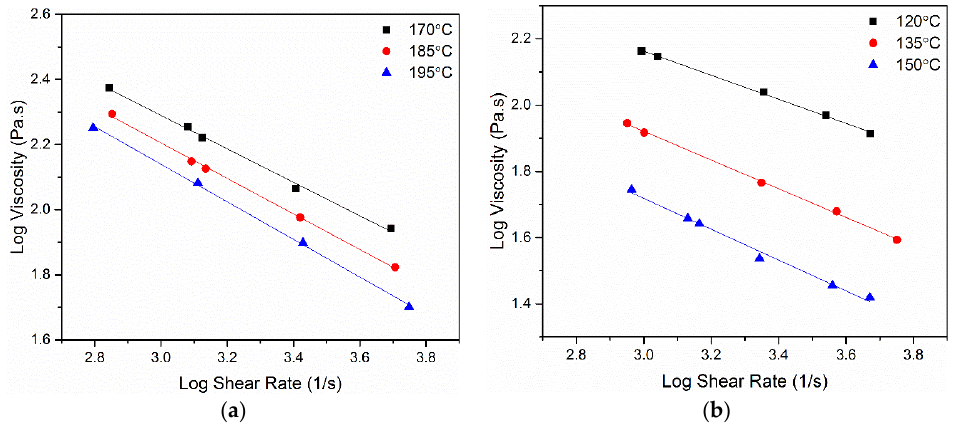
Figure 5. Results of the viscosity measurements for ( a ) the commercial feedstock and ( b ) the current study. Table 2. Flow behaviour index and yield stresses for commercial and current feedstocks. Feedstock Temperature ( ◦